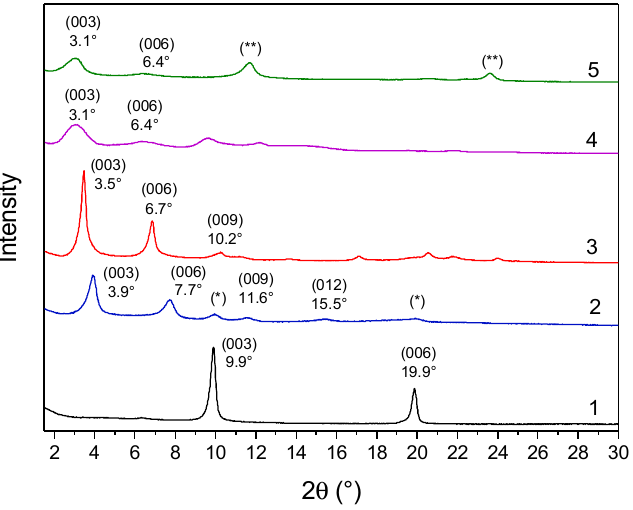
Figure 2. XRD patterns of samples LDH-NO 3 (1), LDH-RA (2), LDH-DS/RA (3), LDH-GA (4), and LDH-DS/GA (5). Reflections (*) are likely due to a small fraction of unexchanged LDH-NO 3 . Reflection (**) at 11.7° and 23.6° are probably due to the intercalation of carbonate anions that occurred during the preparation or purification of the host–guest system.